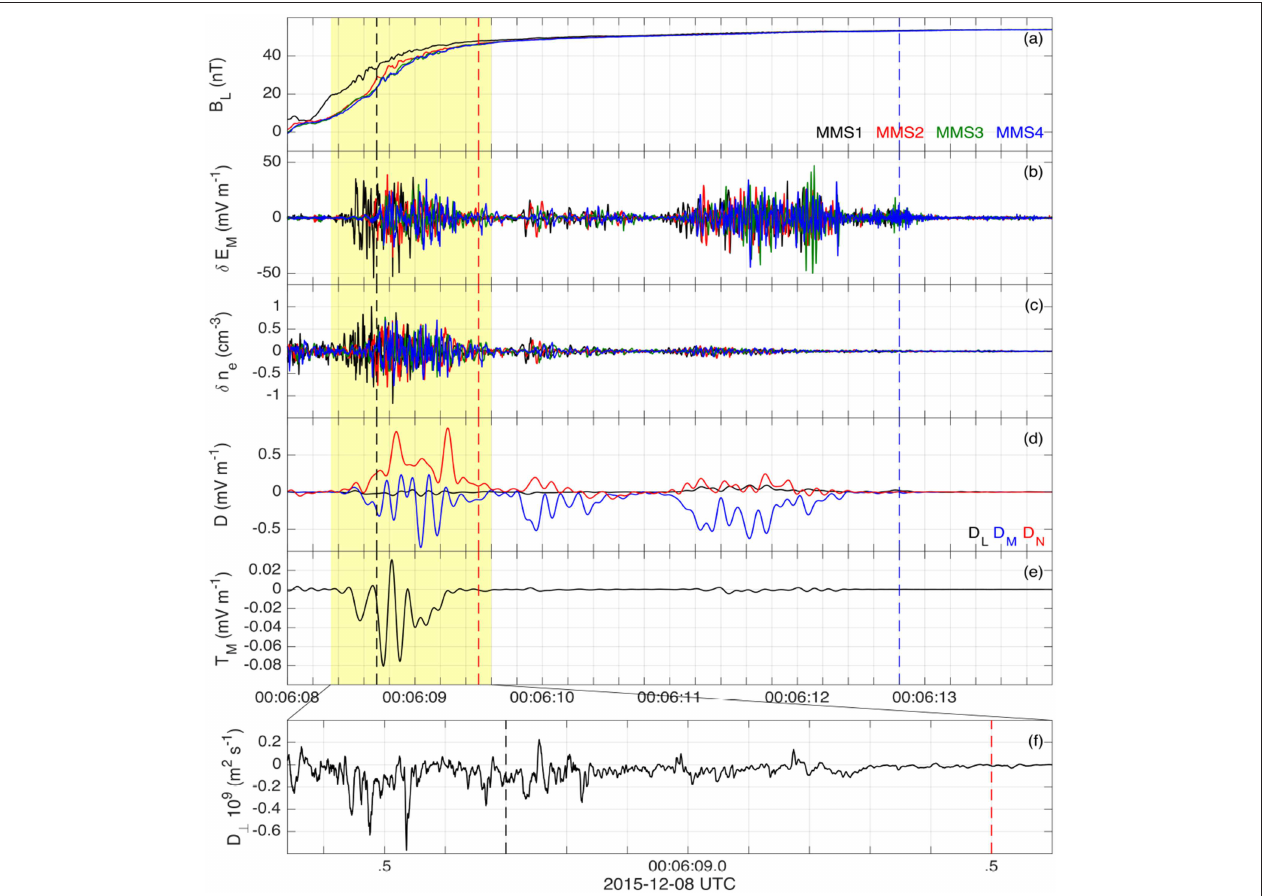
FIGURE 9 | Anomalous terms associated with the LH waves at a reconnecting magnetopause. Figure is reproduced from Graham et al. (2017b). (a) B L obtained from the four MMS spacecraft. (b) δ E M associated with LH waves. (c) δ n e associated with LH waves inferred from the spacecraft potential. (d,e) Anomalous drag D and anomalous viscosity T M in the M direction estimated over the four spacecraft. (f) Cross-field diffusion coefficient D waves averaged over the four spacecraft. The black, red, and blue dashed lines mark the diffusion region, peak parallel electron heating, and ion edge, respectively (defined in Graham et al.,